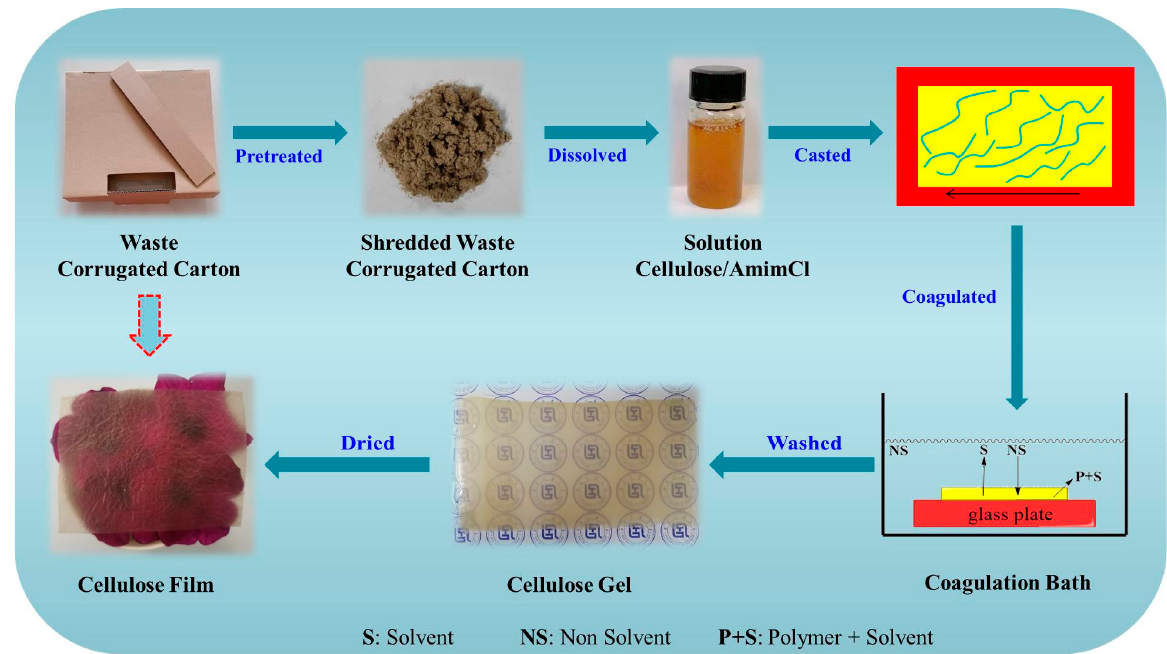
Figure 1. Preparation scheme of cellulose-based films from old waste corrugated cartons.